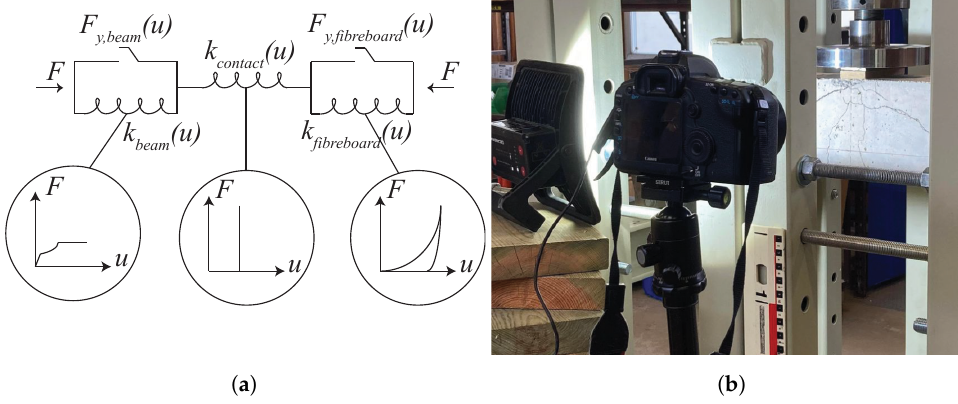
Figure 4. ( a ) System with springs in series and ( b ) DIC